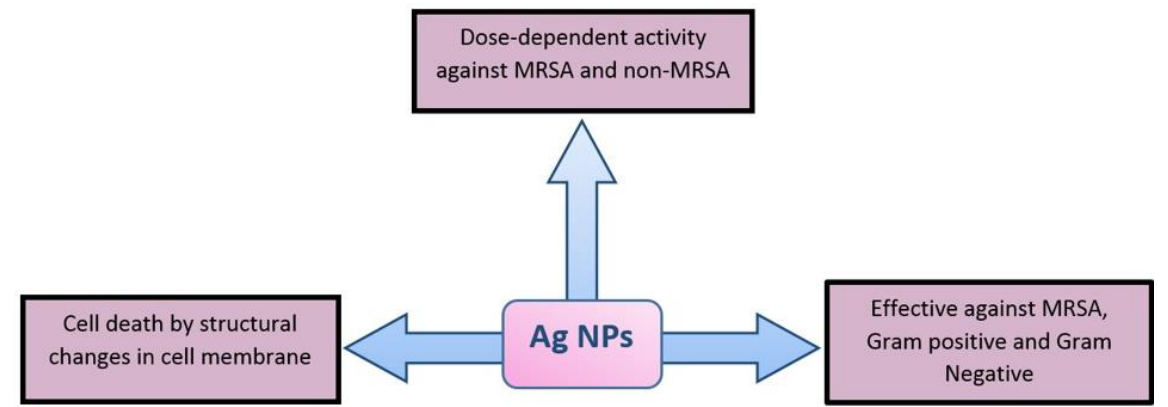
Figure 4. Mode of action (bactericidal effects) of AgNPs against bacteria against MRSA.